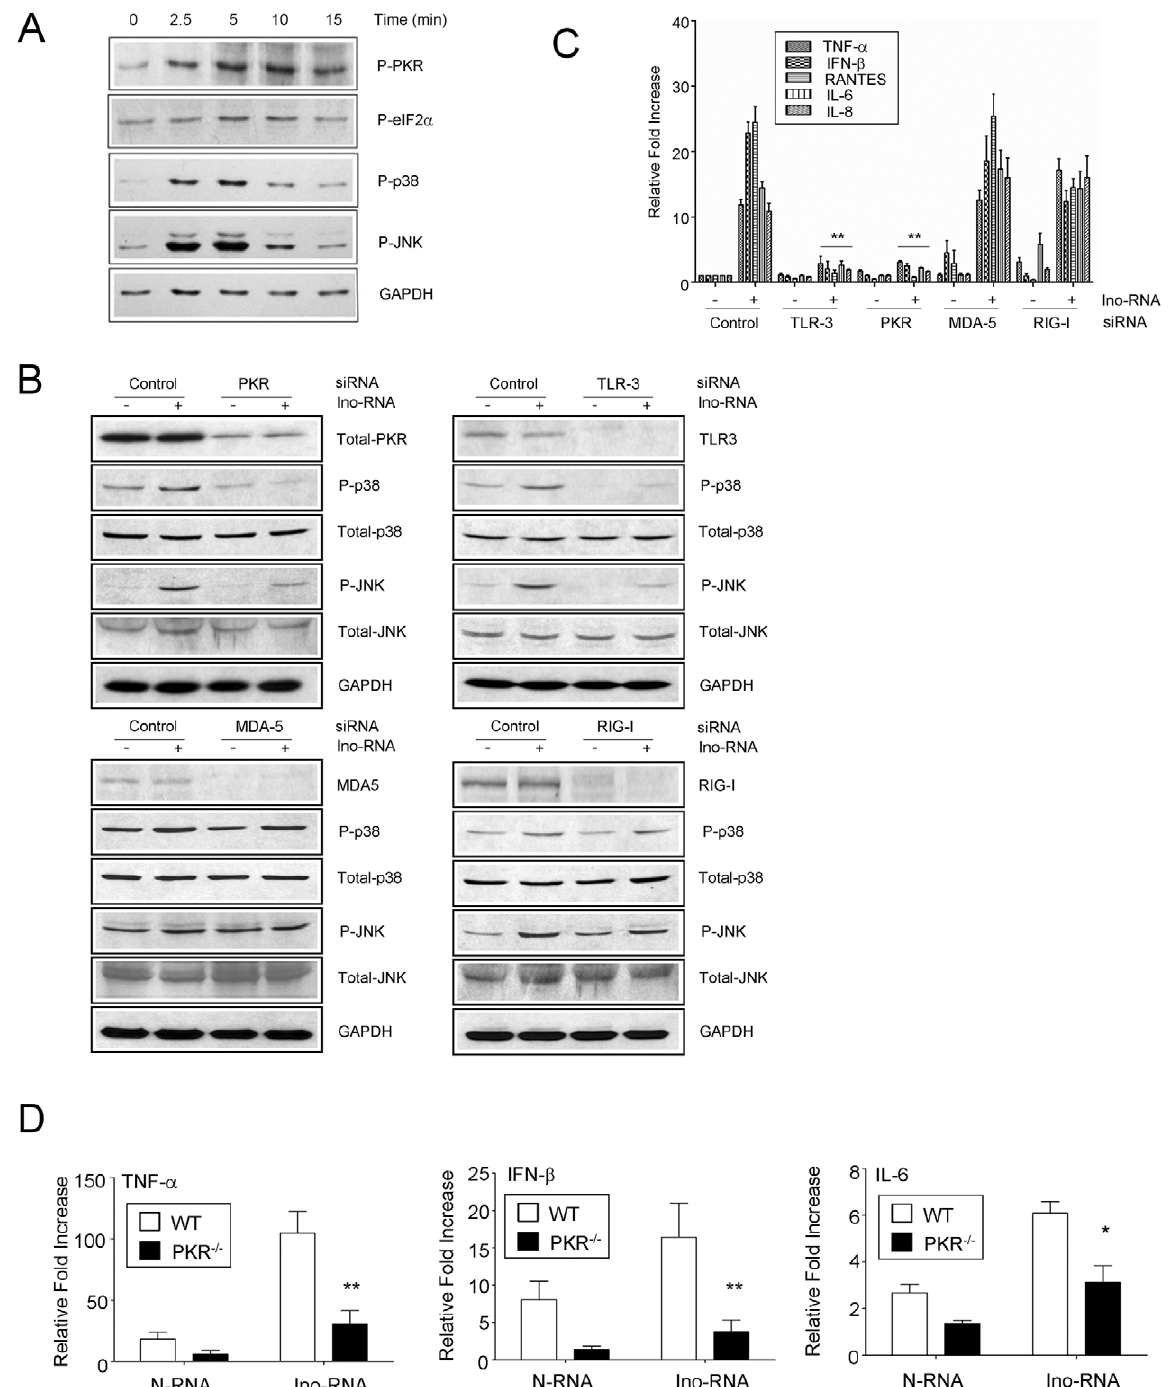
Figure 7. Ino-RNA-induced signaling pathways. Panel A , For analysis of innate inflammatory signaling pathways, PHBE cells were treated with Ino-RNA at 10 m g/ml and at indicated time points, total cellular protein extracts were prepared by cell lysis using 1X SDS-PAGE buffer. Phospho- proteins were probed using specific antibodies, and were visualized by the enhanced chemiluminescence detection. Panel B , For the activation of MAPKs detection, PKR, TLR3, MDA5 and RIG-I were treated by chemically synthesized siRNAs and then by 10% Ino-RNA. We next performed analysis of Ino-RNA induction of inflammatory cytokines following PKR, TLR3, MDA5 and RIG-I siRNA knockdown ( Panel C , n=3). Mock siRNA-treated cells were used as a control. Panel D , PKR-deficient mice or wild-type controls (4 in each group, n=3) were treated intratracheally with 25 m l (1 mg/ml) of Ino-RNA or with 25 m l of PBS (vehicle control). After 4 hr, total lung RNA was isolated for RT-PCR (n=3, 6 SEM, *p , 0.05, ** p , 0.01).